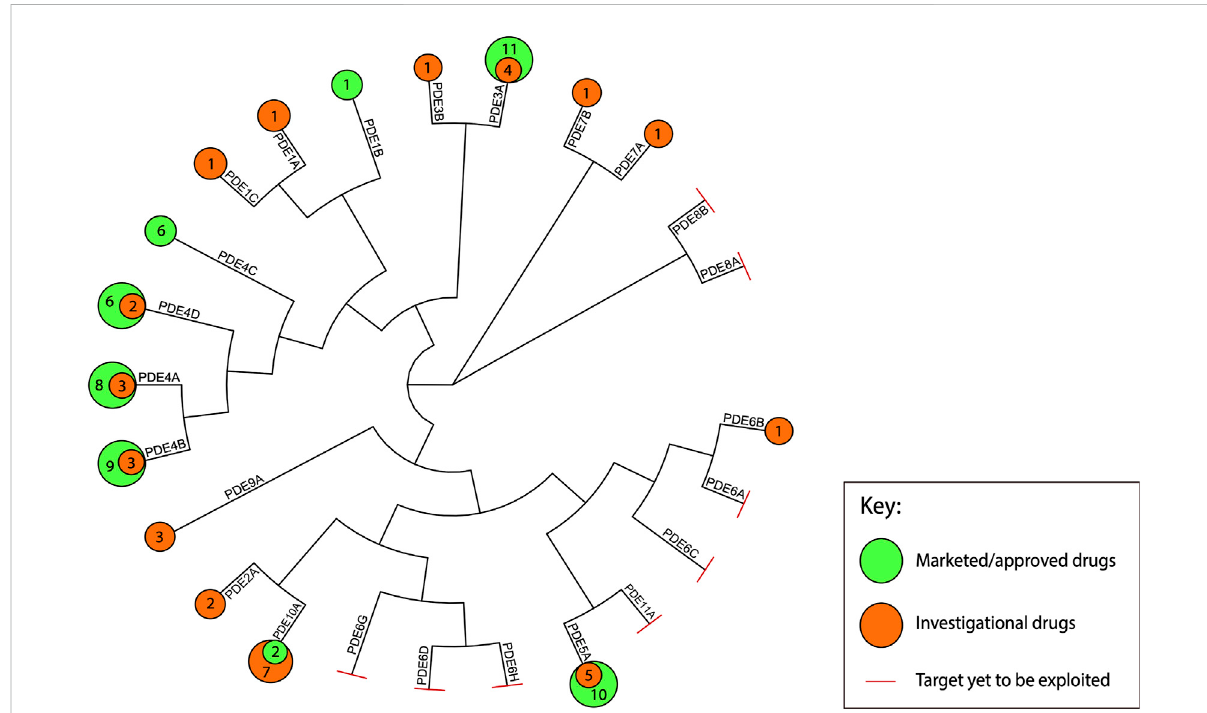
FIGURE 2 Marketed and investigational PDE inhibitors mapped to the human PDE proteins. This fi gure illustrates the phylogenetic relationship between thehuman PDE isoforms and mapstheidenti fi edmarketedand investigationalagentstotheirtargets.The aminoacid sequences ofeachfor each of thehumanPDEproteinswereobtainedfromUniProt(UniProtKBdatabase)(UniProtConsortium,2021).Multiplesequencealignmentwasperformed usingClustal Omega(RRID:SCR_001591). The phylogenetictree wasvisualized inRStudio (Paradisand Schliep, 2019;Yu, 2020)and annotated in Adobe Illustrator CC